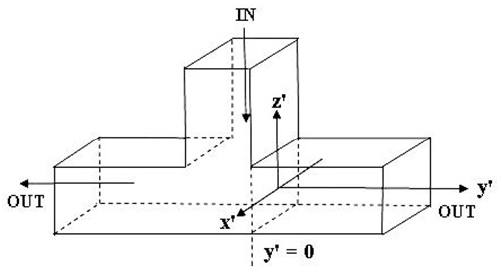
Figure A1. T-cell with a vertical inlet to demonstrate the rapid relaxation to symmetric velocity profiles in the outlet arms.